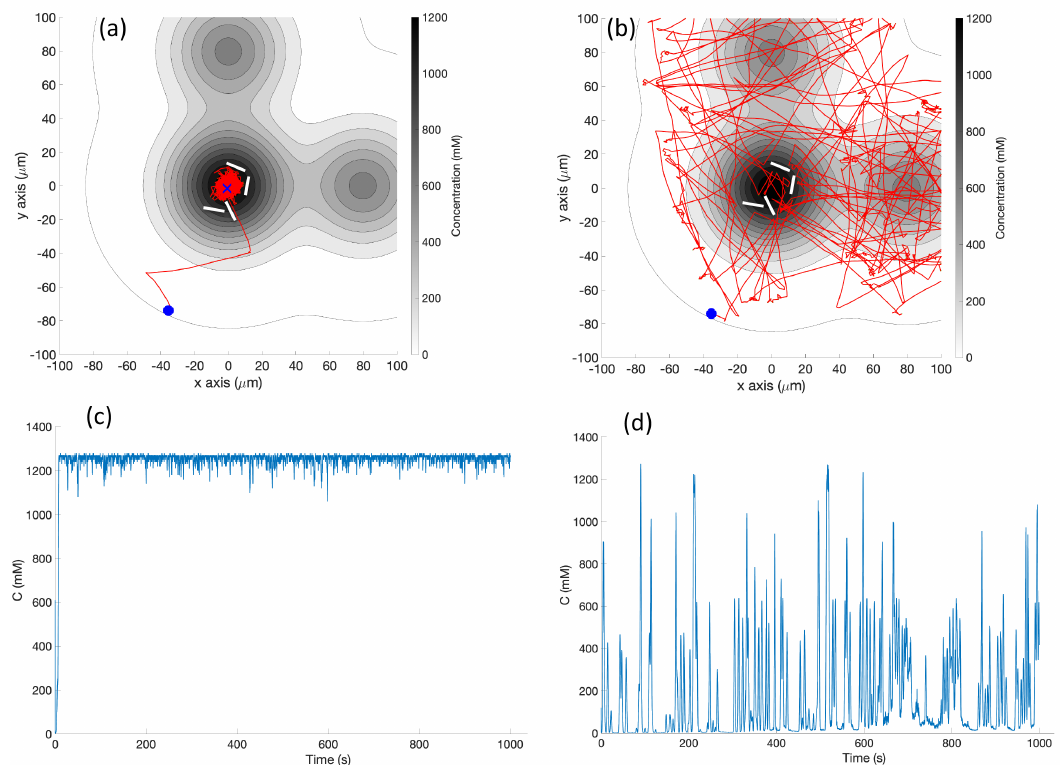
Figure 18. Case 9: With obstacles, in the triple-effluent environment, typical trajectories of the simulated robot running ( a ) the basic chemotaxis controller, and ( b ) the RapidCell chemotaxis controller. The contour plot represents the concentration distribution shown in Figure 5 (right) where the outmost level curve represents the concentration at 1m M . In each trajectory, the initial position is shown as a blue circle and the terminal position is shown as a blue “X”. Positions corresponding to concentrations less than 1m M are shown in dashed green, otherwise shown in red. The recorded concentrations associated with each scheme are shown in ( c , d )